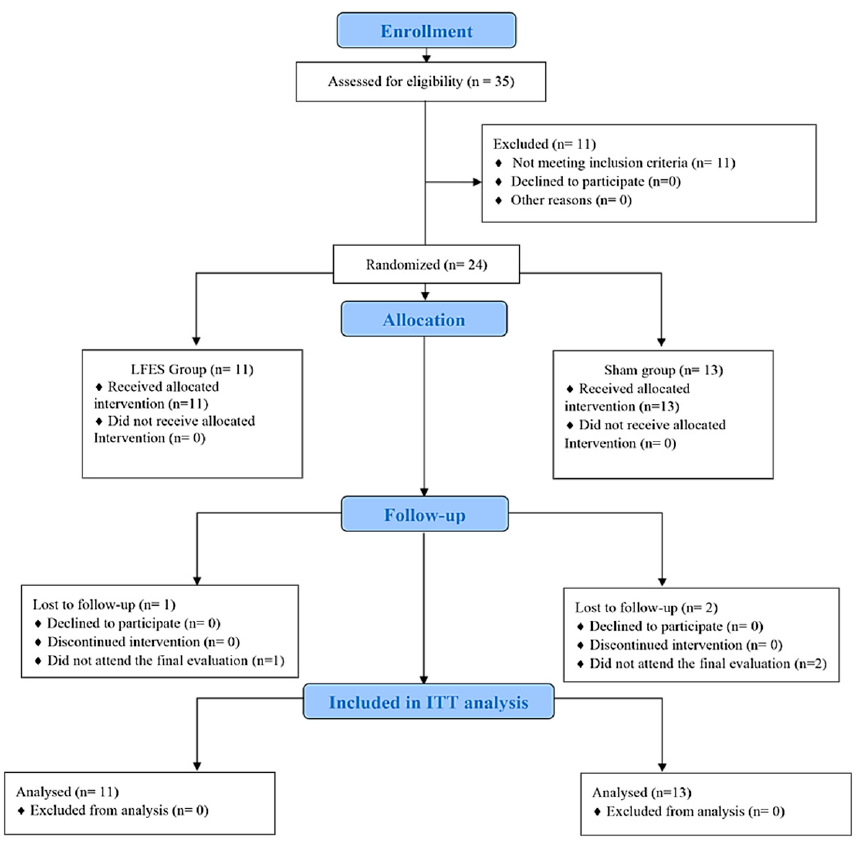
Figure 1. Flowchart of the randomized trial.